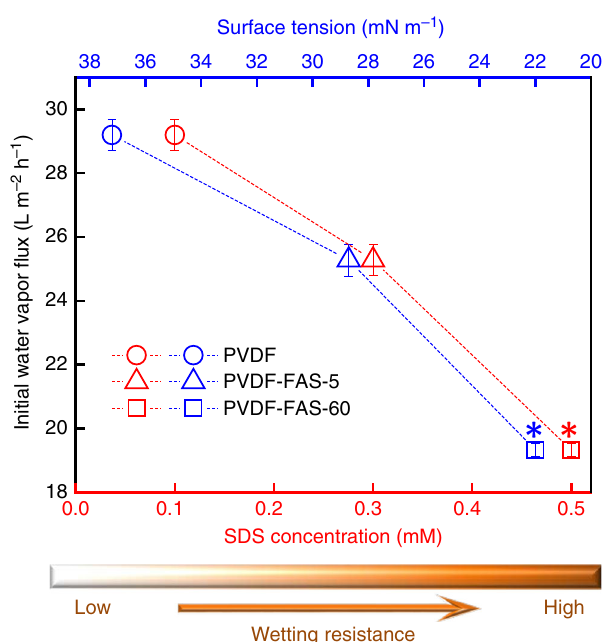
Fig. 3 The relationship between initial water vapor fl ux and wetting resistance of different MD membranes tested in this study. The blue and red symbols refer to the critical surface tension and the critical SDS concentration, respectively, at which each membrane was completely wetted. Membranes with enhanced wetting resistance tolerate liquids with lower surface tensions and higher concentrations of SDS. The asterisks indicate that our omniphobic membrane was indeed not fully wetted by ethanol (in contact angle measurement) or 0.4 mM SDS (in DCMD desalination). Error bars represent standard deviation from